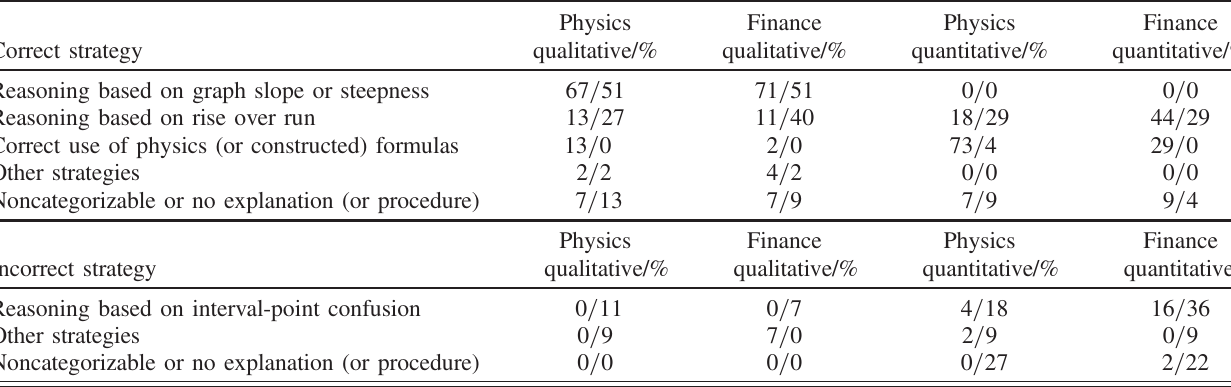
TABLE III. An overview of strategies used by students for the slope questions. The left numbers show percentages of physics students and the right numbers percentages of psychology students who used a particular